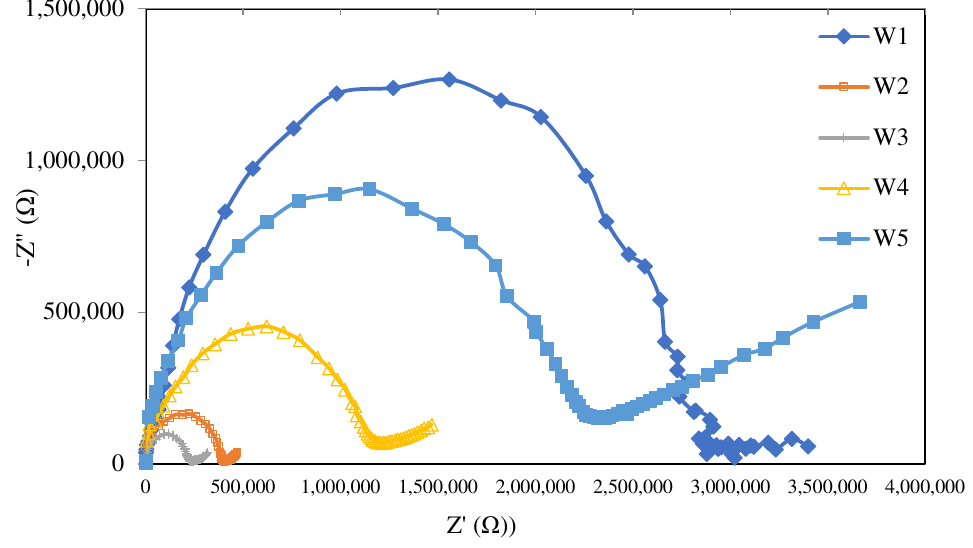
Figure 7. The Nyquist plots of the membrane samples at different MWCNT content amounts with an open-circuit voltage between 10 μHz and 10 MHz.